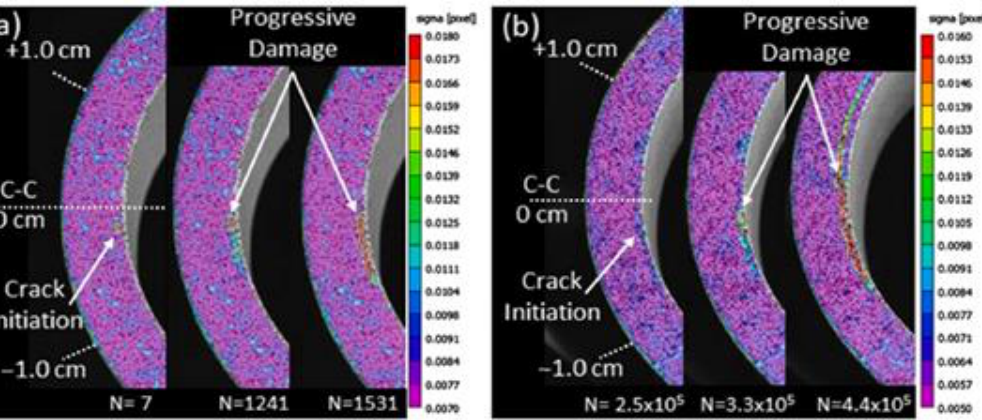
Figure 6. DIC images showing progressive damage for ( a ) P MAX = 90% and ( b ) P MAX = 70% using the correlation coefficient “sigma” [9].